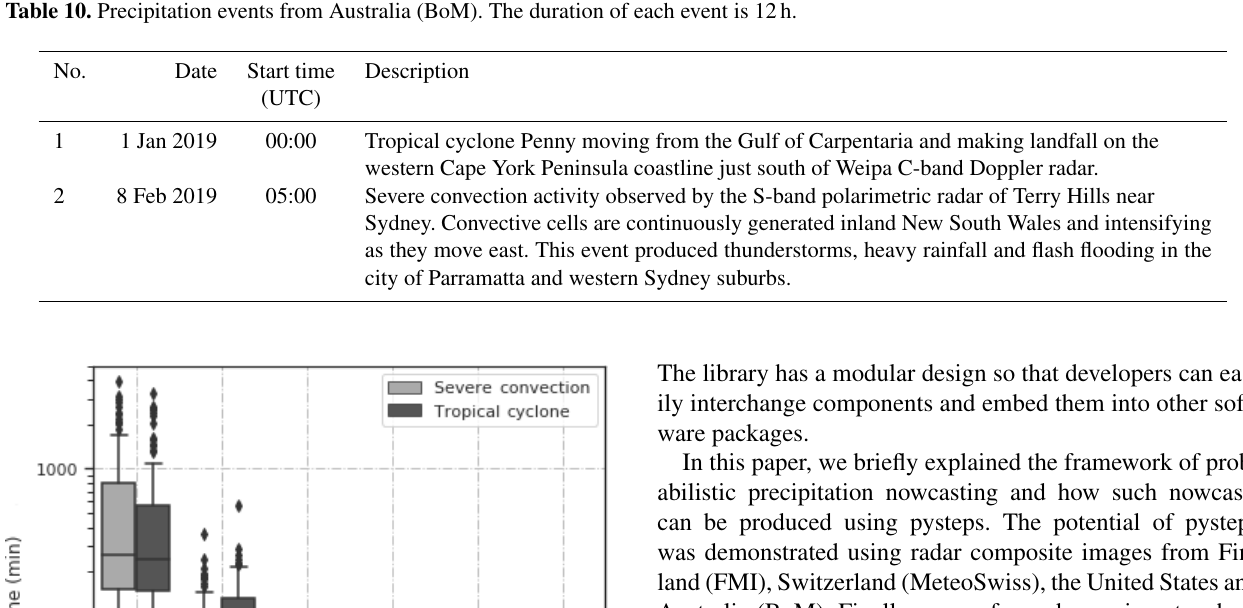
Table 10. Precipitation events from Australia (BoM). The duration of each event is 12h.